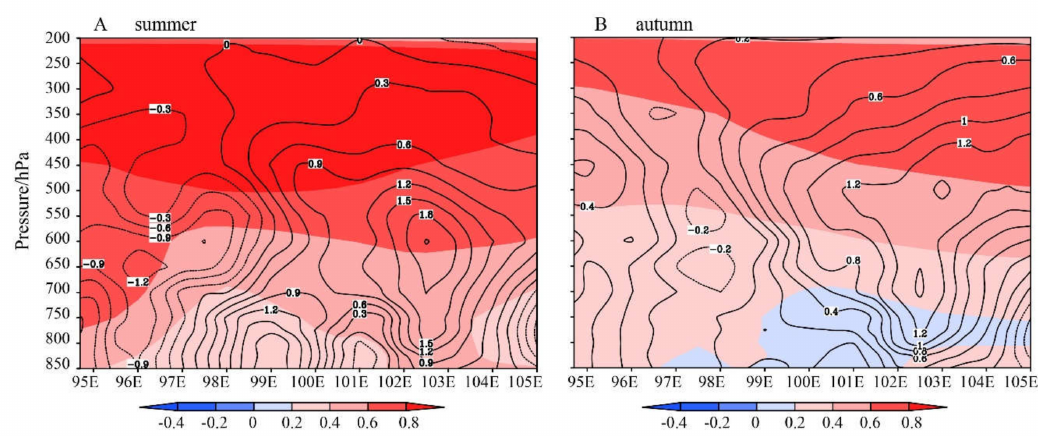
Figure 9. The differences in temperature (shading; unit: ◦ C) and vertical velocity (contour line; unit: − 0.01 Pa s − 1 ) for 1998–2014 subtract 1984–1997 on the vertical cross section of the HRB (38N–40N) for summer ( A ) and autumn ( B